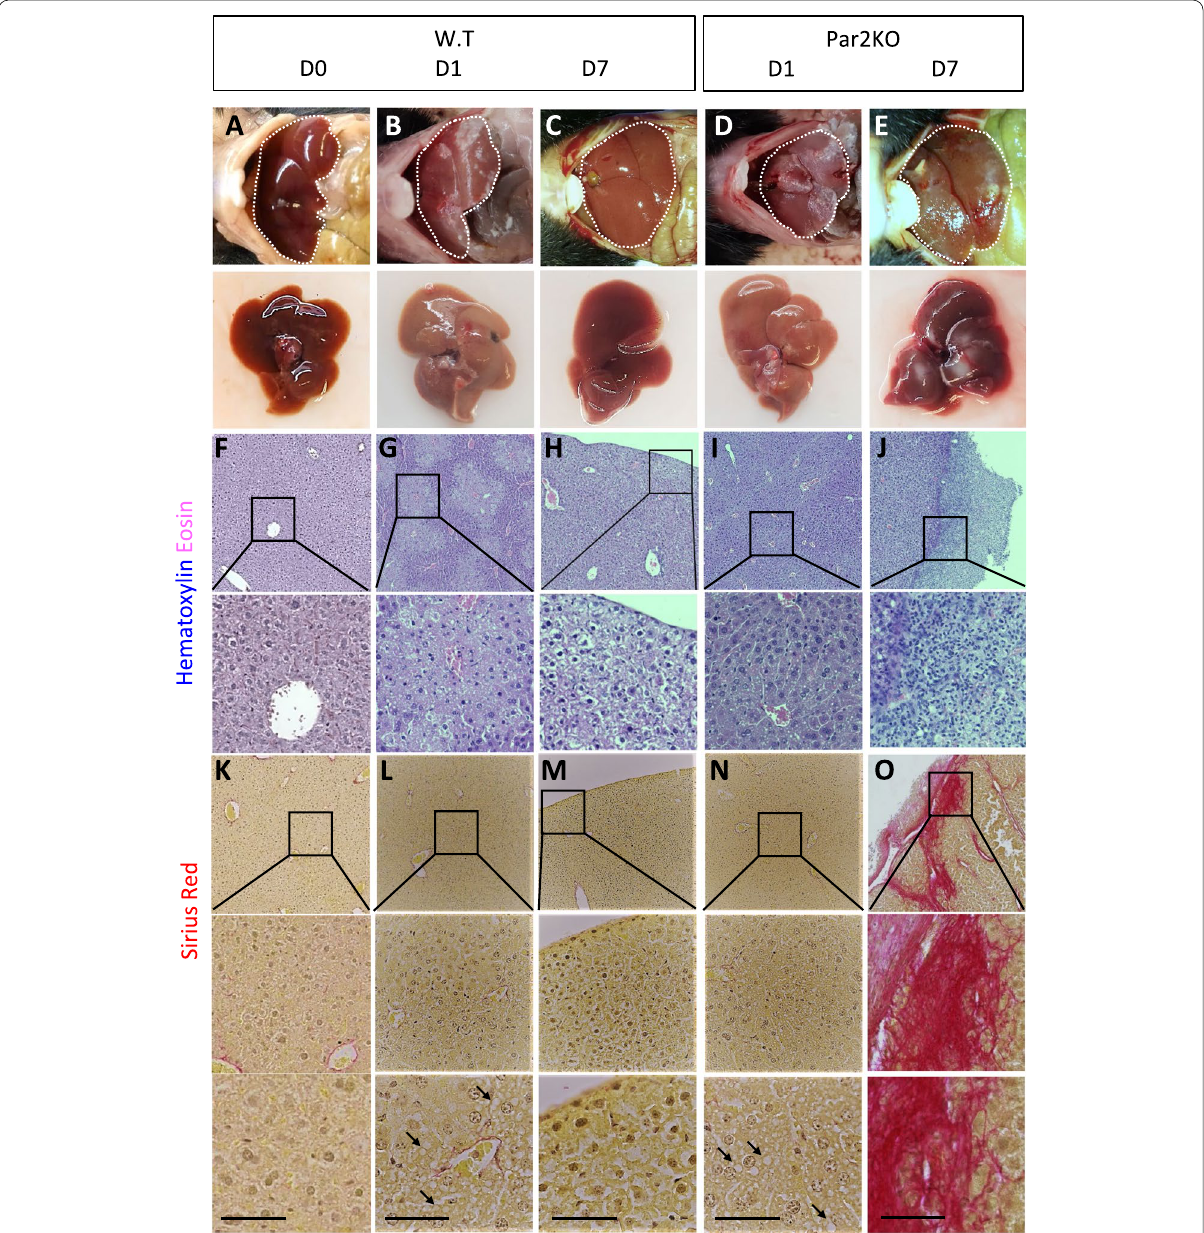
Fig. 7 Par2 promotes regeneration in hepatocytes after CCl 4 injection. WT mice recovered from the tissue damage caused by CCl 4 while Par2KO mice failed to recover. A , F , and K . WT mouse before CCl 4 injection. B , G , and L . WT 1 day after injection: fat vacuoles (arrows) indicate hepatic steatosis. C , H , and M . WT 7 days after injection: the tissue recovered. D , I , and N . Par2KO mice 1 day after CCl 4 injection: fat vacuoles (arrows) indicate hepatic steatosis. E , J , and O . Par2KO mice 7 days after injection: necrotic lesions (E, J) and collagen fibers (O in pink) appeared. A‑E. Macroscopic images. F‑J. H&E, K‑O . Sirius Red. Scale bar =